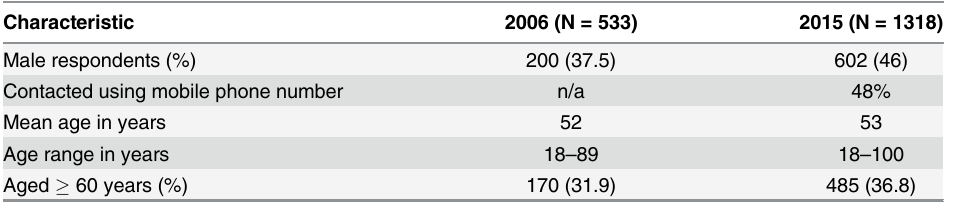
Table 1. Characteristics of survey respondents 2006,